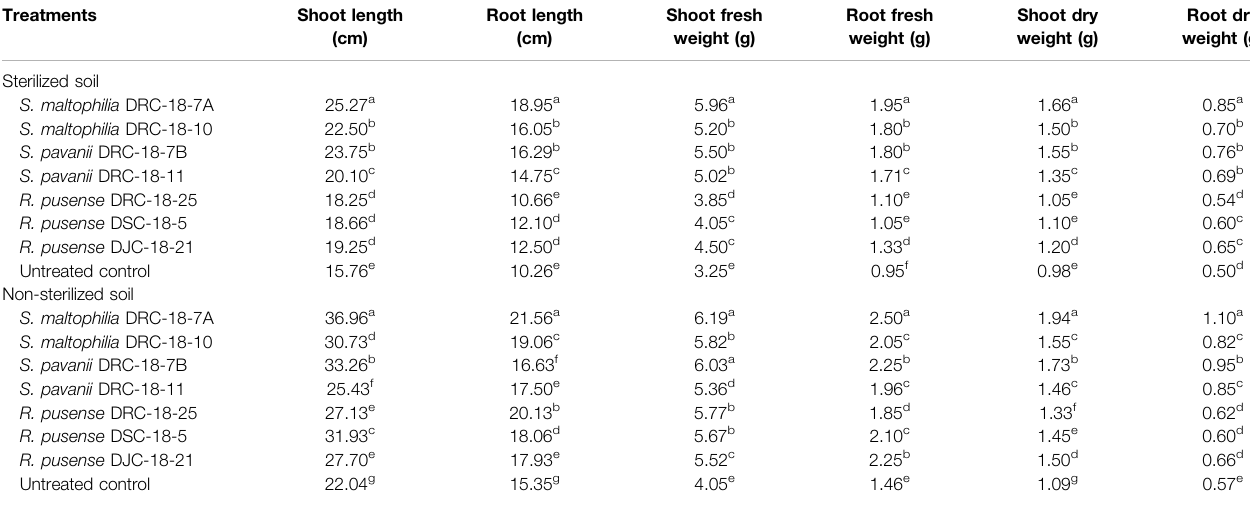
TABLE 4 | Effect of seed inoculation on plant growth parameters of pigeonpea grown in pots after 30 days of sowing. Treatments